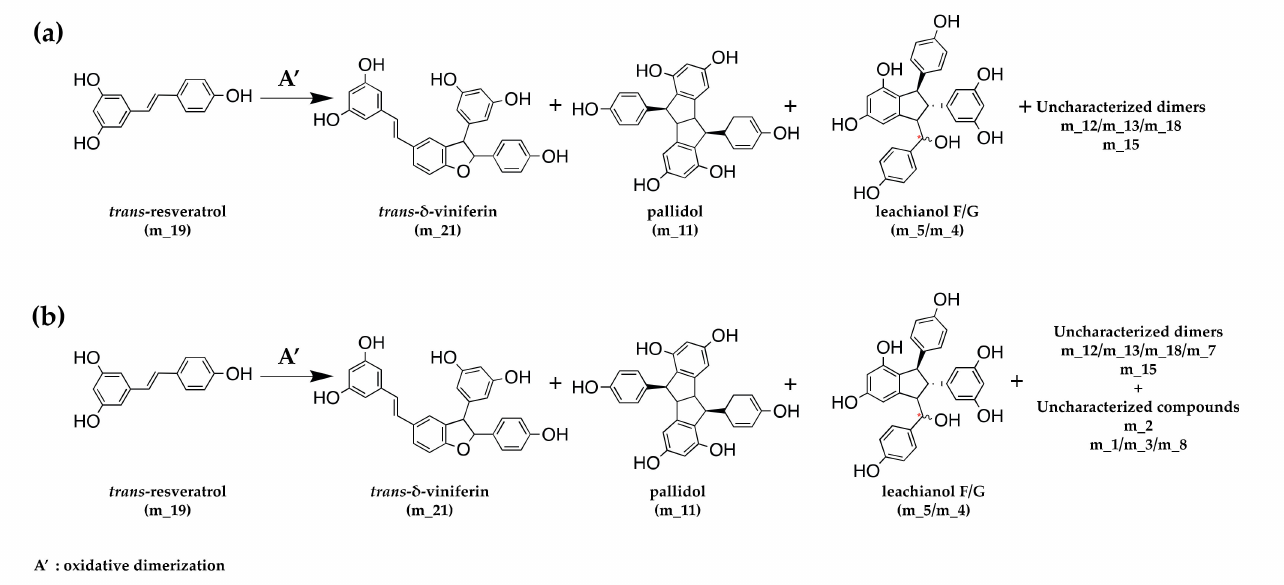
Figure 6. Schematic oxidative dimerization of trans -resveratrol by fungal extracellular proteins from ( a ) D. seriata and ( b ) N. parvum